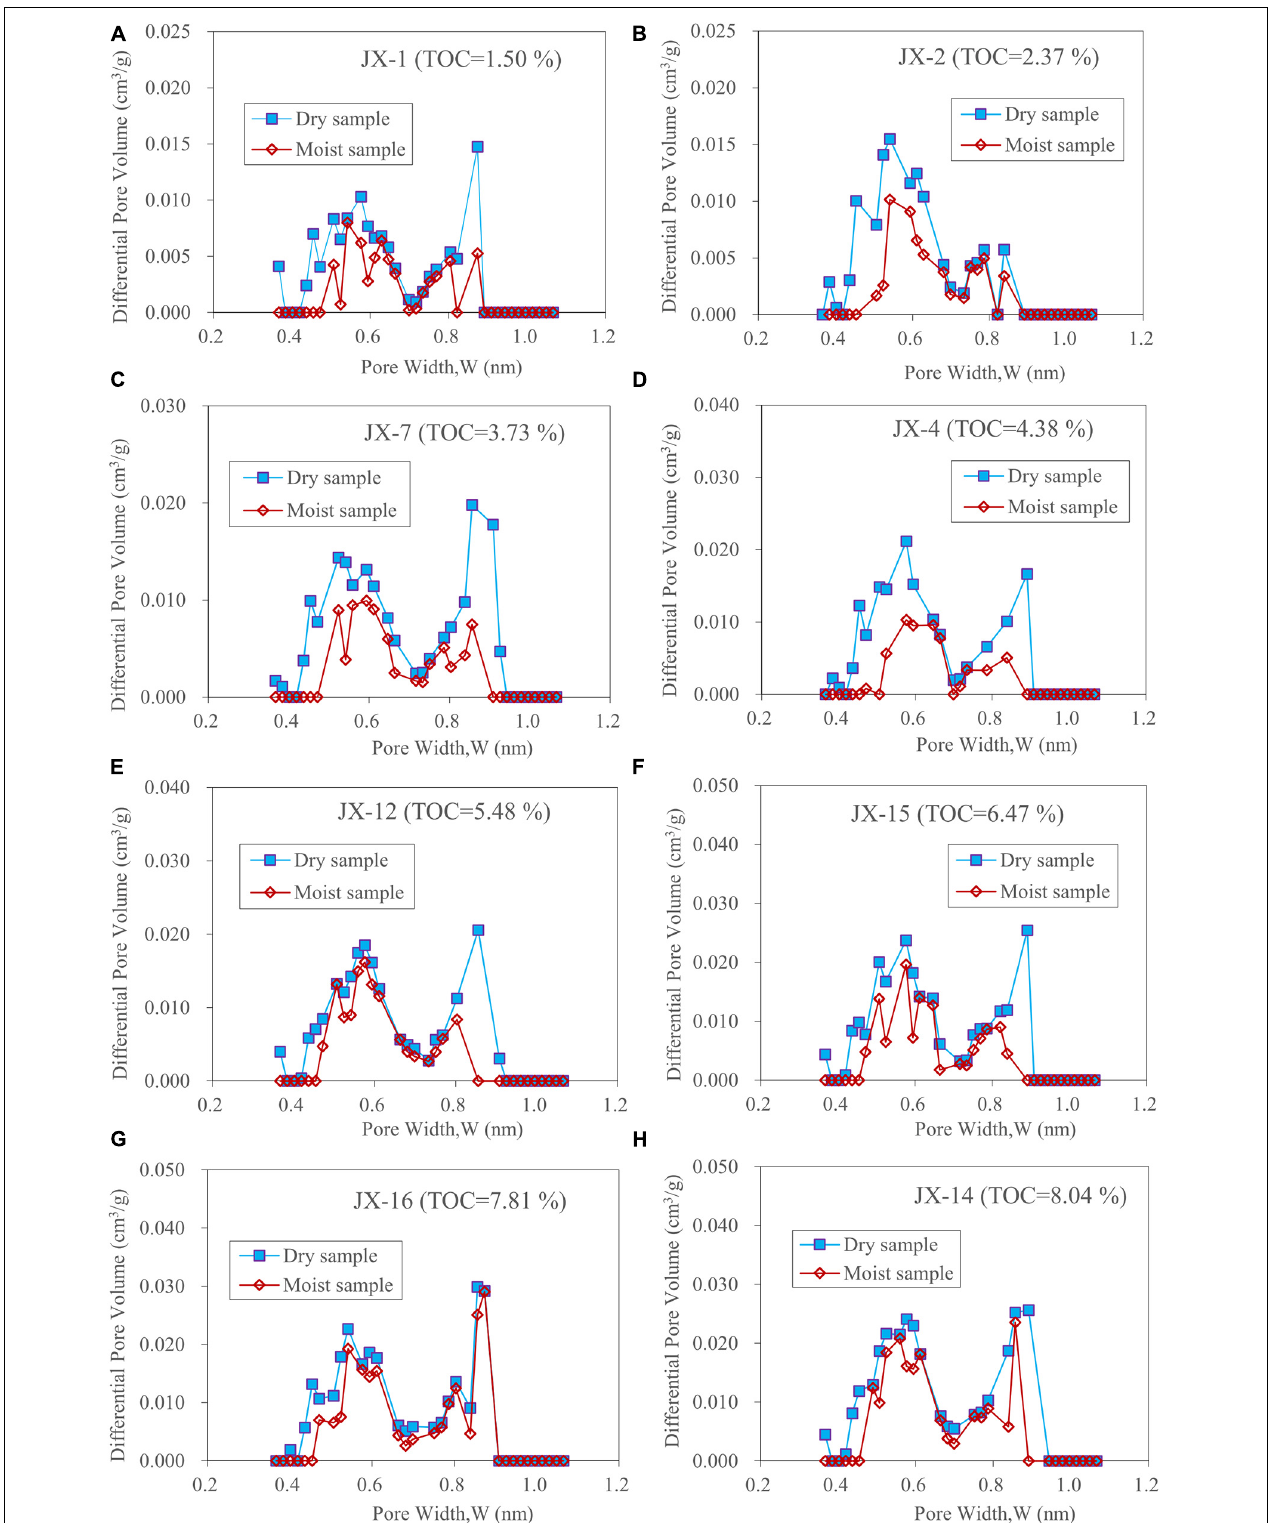
FIGURE 5 | Plots showing the pore-size distribution of the selected 8 pairs (dry and moist) samples based on the CO 2 adsorption analysis (A–H) . There is no distinct difference between the dry and moist samples.